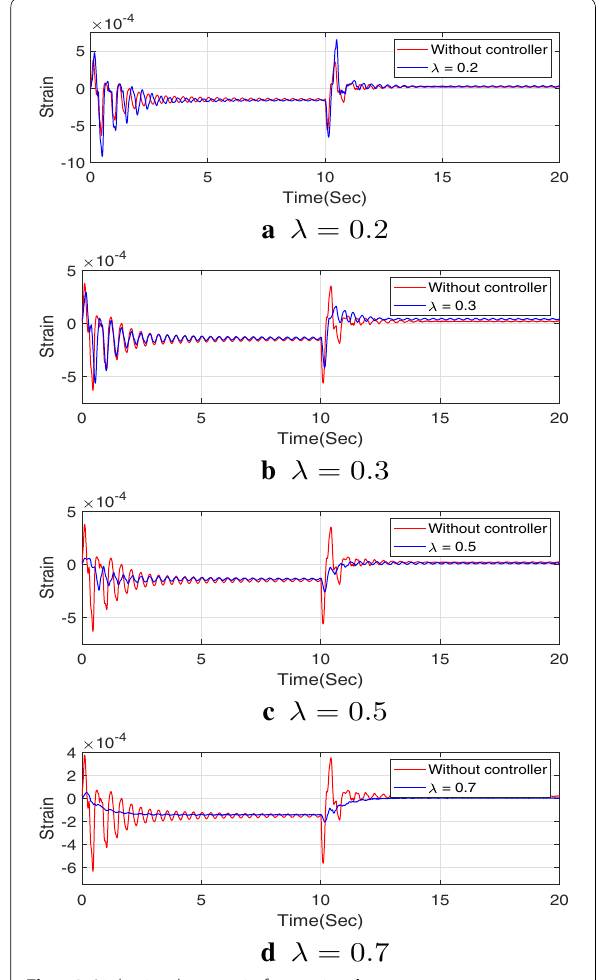
0.2, 0.3, 0.5 and 0.7 =